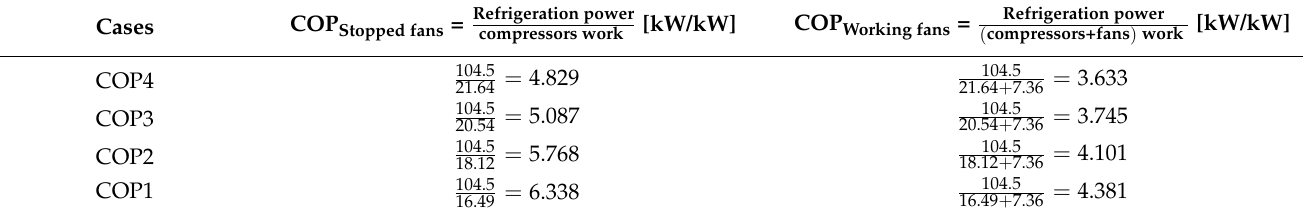
Table 5. COP values for different operative conditions (COP just compressors; COP evaporator and condenser with fans. Cases